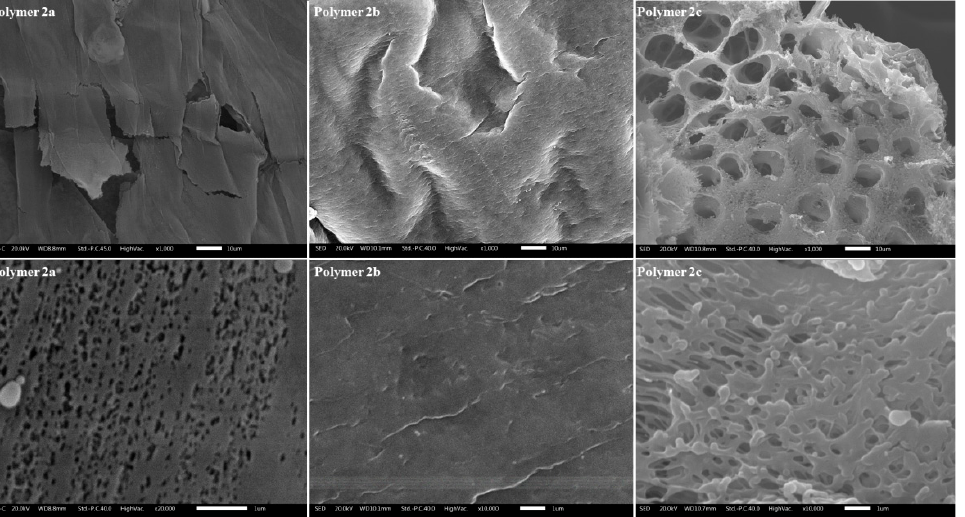
Figure 11. SEM images of the raw polymers bearing thiol moieties. Low image magnification ( top ) and high image magnification ( bottom ). The scales are 10 μ m and 1 μ m, respectively.